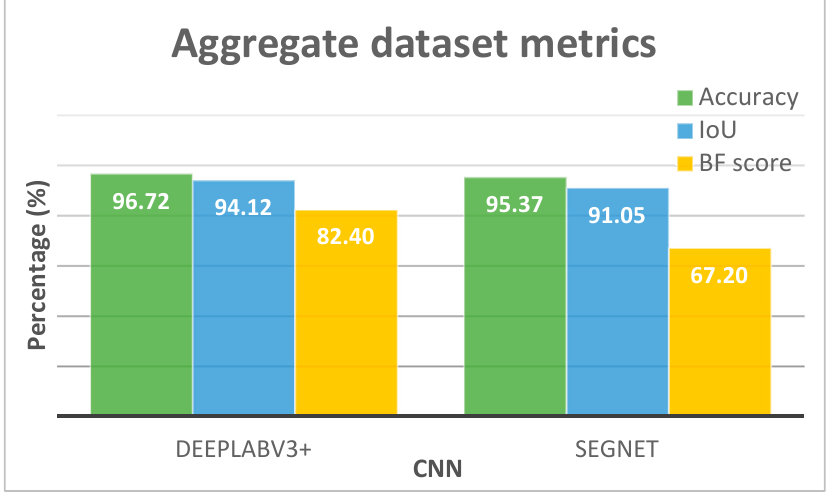
Figure 6. A comparison of segmentation metrics for the entire dataset for both DeepLabv3+ and